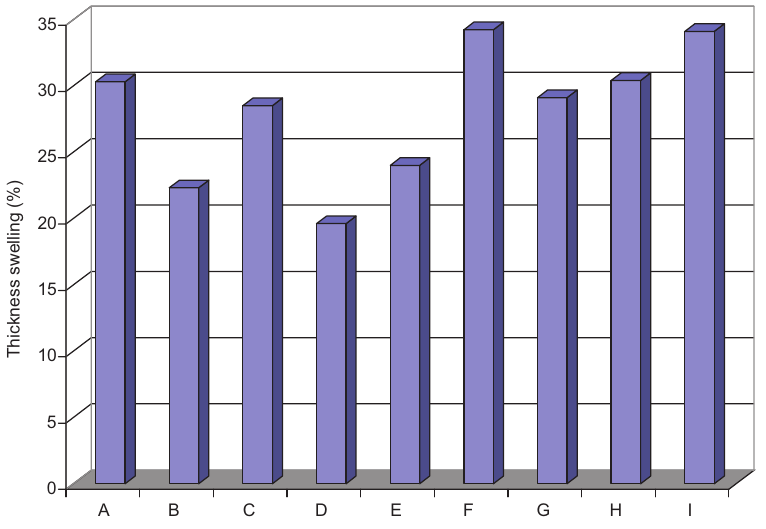
Figure 5 Thickness swelling properties of